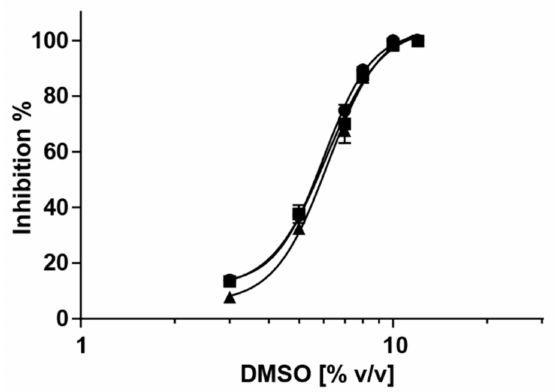
Figure 2. Inhibition curves of DMSO against S. aureus at 34 ◦ C (circle, • ), 37 ◦ C (square, (cid:4) ) and 40 ◦ C (triangle, (cid:78) ). Measurements performed in triplicates on individual days and plotted as mean inhibition (%) ± standard deviations against DMSO (% v / v ).